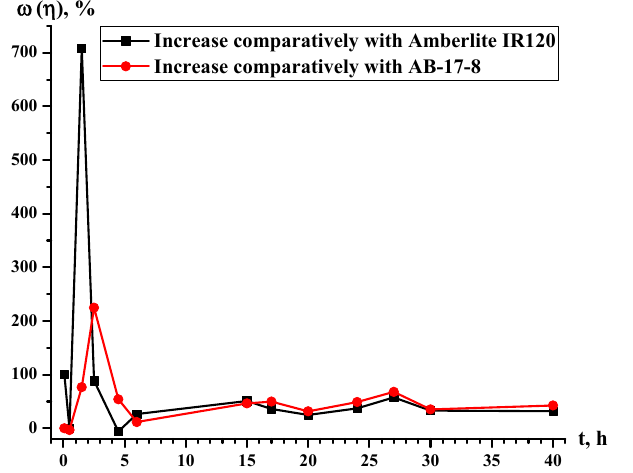
Figure 16. Increase of extraction degree in interpolymer pair Amberlite IR120:AB-17-8 = 1:5 relatively individual Amberlite IR120 and AB-17-8. Table 4 represents growth of extraction degree of europium ions of the intergel pair compared with individual polymer structures of Amberlite IR120 and AB-17-8. Growth of the polymer chain binding degree at the ratio Amberlite IR120:AB-17-8 = 1:5 occurs rather fast during 2.5 h of remote interaction (Figure 17). Binding degree increases up to 725.00% compared with individual Amberlite IR120 at 1.5 h of interaction, while the maximum growth relative to AB-17-8 (211.76%) is observed at 2.5 h. Due to